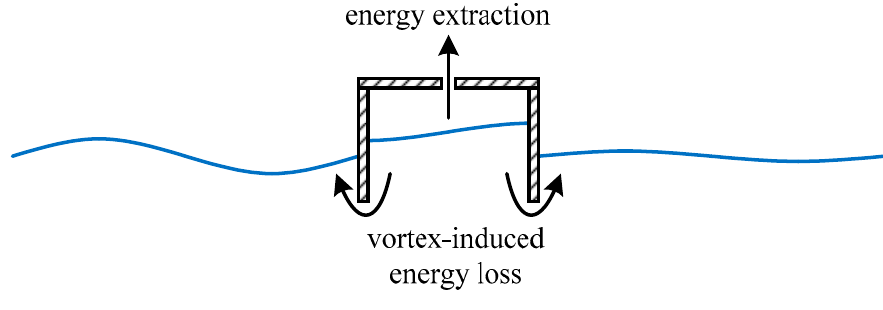
Figure 1. An illustration of two sources of wave energy dissipation by an OWC structure.